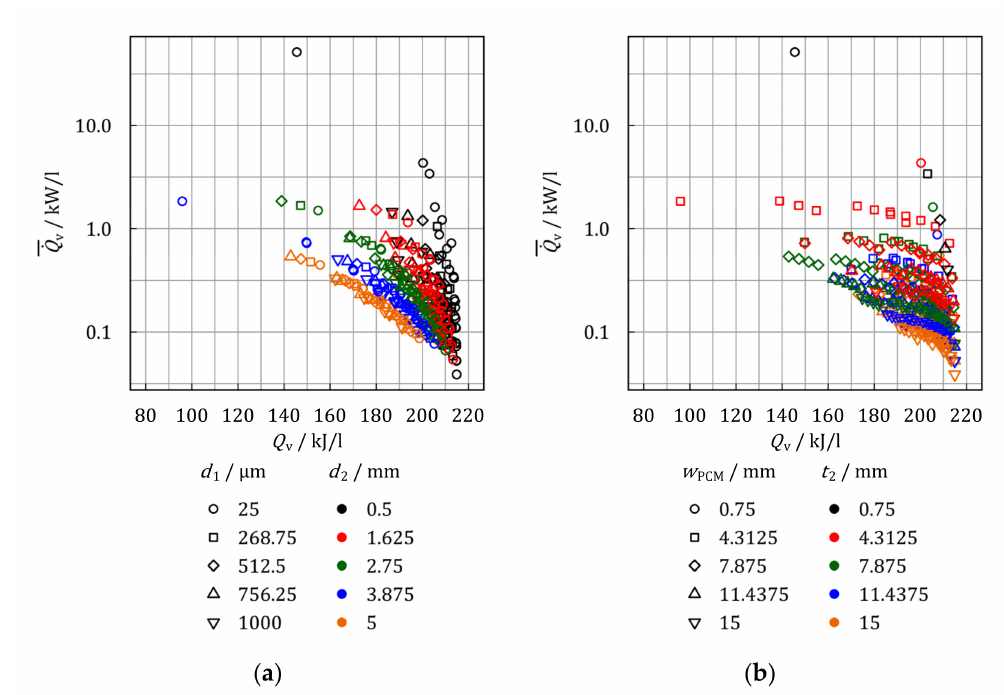
Figure 17. Mean volume specific power in logarithmic scale vs. volume specific storage capacity for all variations of the wire cloth heat exchanger in dependency of tube diameter d 2 and wire diameter d 1 ( a ) and in dependency of tube distance t 2 and heat exchanger distance w PCM ( b